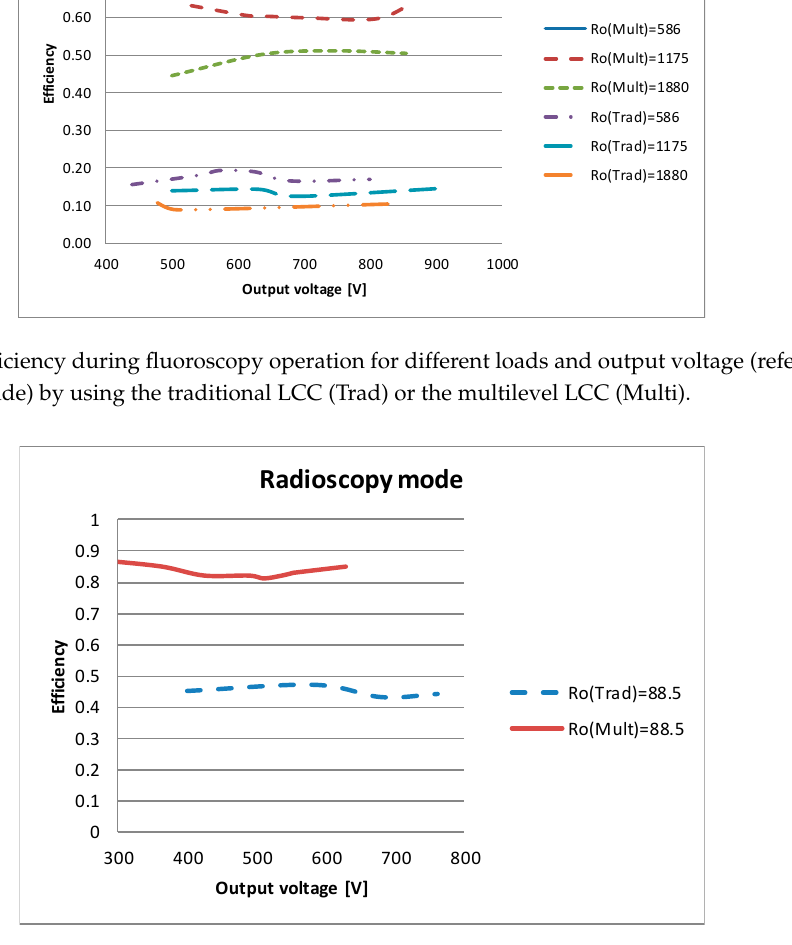
Figure 19. Efficiency during radioscopy operation for different loads and output voltage (referred to the primary side) using the traditional LCC or the multilevel LCC.